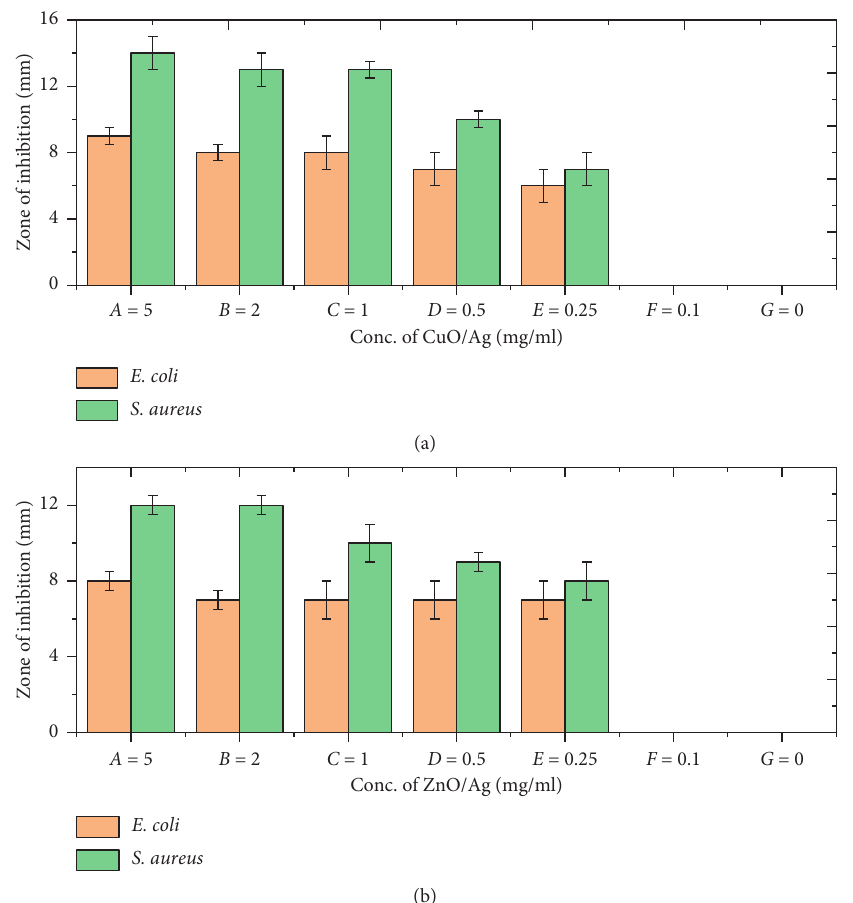
Figure 17: A histogram comparing the activities of (a) CuO/Ag and (b) ZnO/Ag nanocomposites against E . coli and S . aureus . A � 5mg/ml, B � 2mg/ml, C � 1 mg/ml, D � 0.5mg/ml, E � 0.25mg/ml, F � 0.1mg/ml, and G � 0mg/ml. Table 2: Minimum inhibition concentration (MIC) values of nanocomposites against bacteria species. Nanocomposite